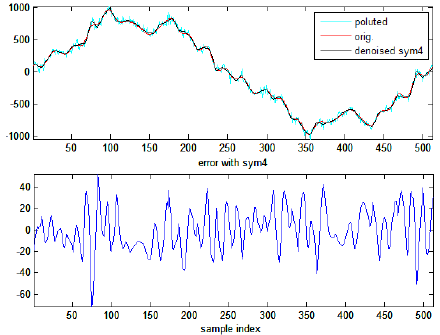
Figure 9. Simulated and computed noises pow- ers (left) and the signal to noise ratios (right) for the 1-st set of analyzed signals.